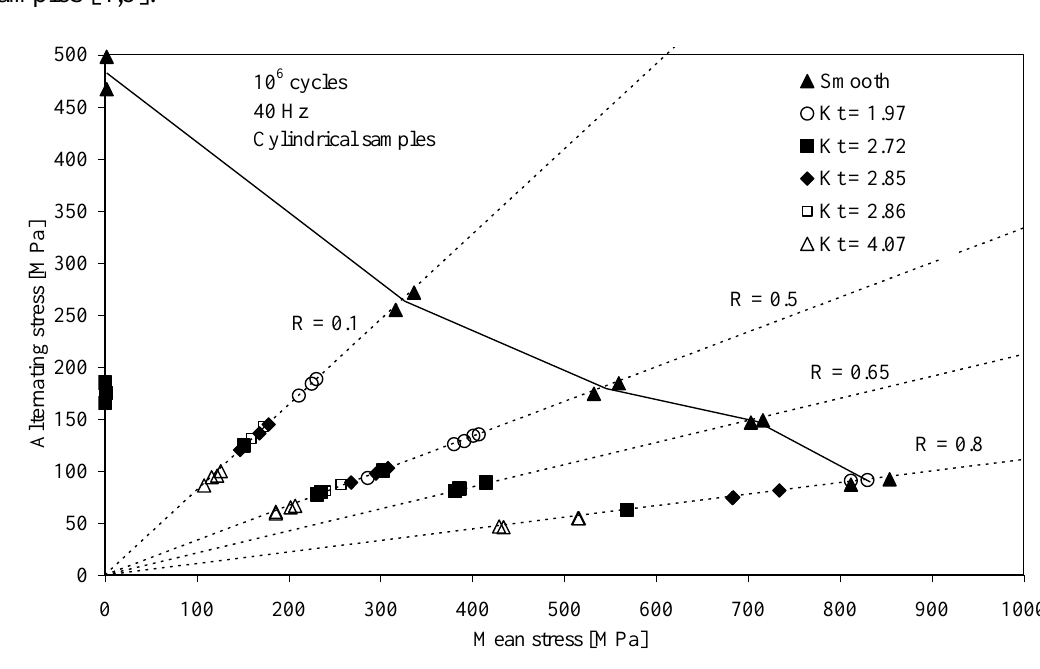
Figure 1. Haigh diagram for a constant life of 10 6 cycles; smooth and notched Ti-6Al-4V samples [4,5].